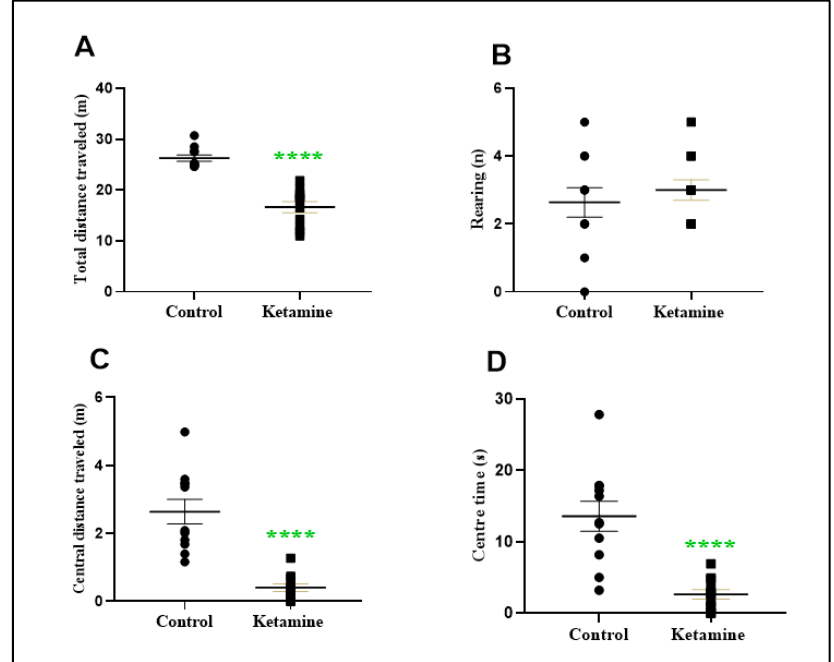
Figure 2. Effects of ketamine recreational regimen (10 mg/kg/day for 3 days, i.p) or saline (control group) in the early withdrawal (24 h) stage on open field test of adolescent female Wistar rats ( n = 10 animals/group). Panel ( A ) represents the total distance traveled; Panel ( B ) represents the vertical exploitation in absolute numbers; Panel ( C ) represents the central distance traveled in meters; Panel ( D ) represents the time spent in central area. Results were expressed as mean ± S.E.M. **** p < 0.0001 compared to control group. Student t-test.